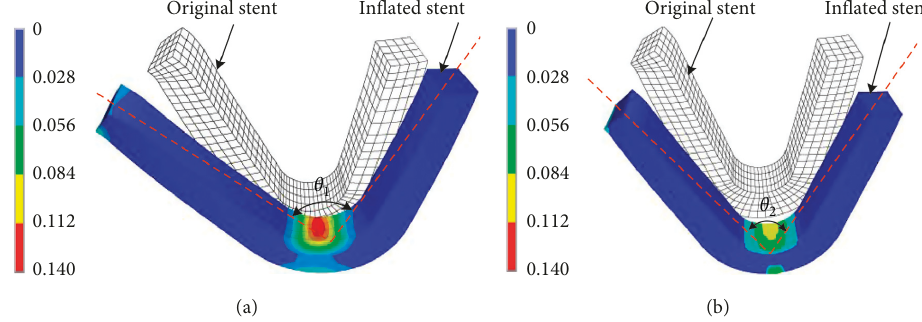
Figure 13: Local deformations of the stents at the inflated state: the supporting element of (a) the OCS and (b) the BVS.